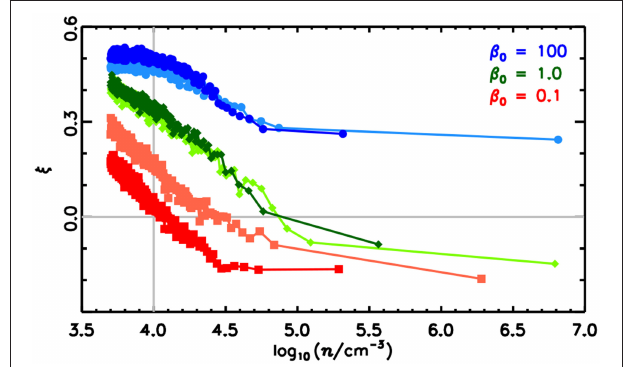
ρ/µ from ≡ ρ ∇ 0. The darker colors = 10 4 cm − 3 . =